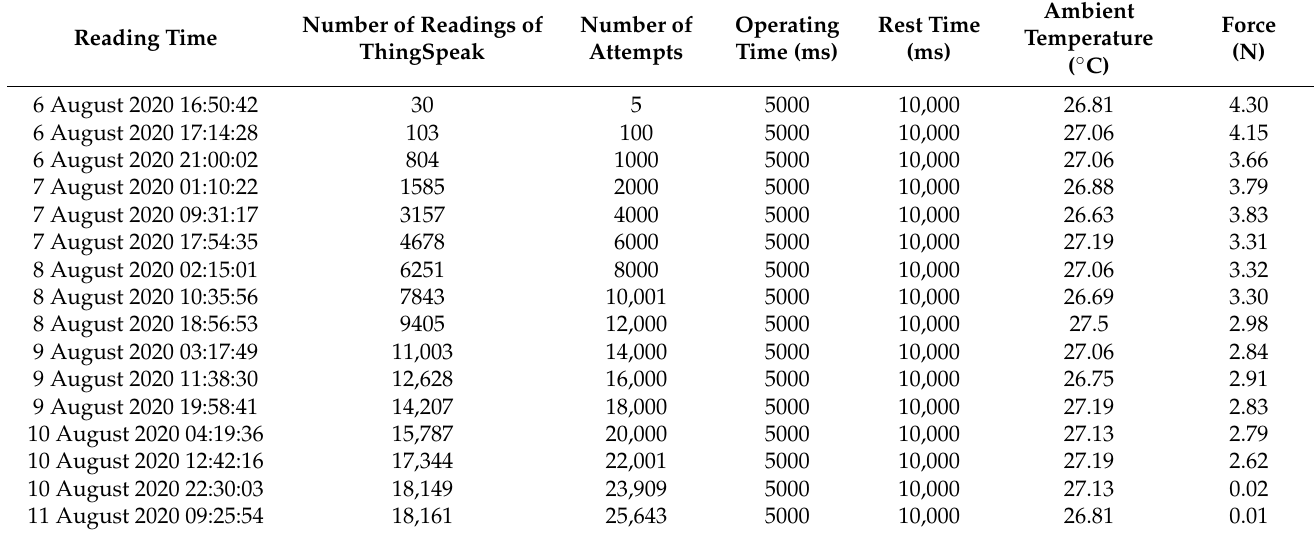
Figure 6. Temperature distribution on the nitinol spring recorded with a thermal imaging camera, tested in the second stage: ( a ) operating period; ( b ) rest period. Table 2. Experimental results obtained for I 2 = 0.914 A.